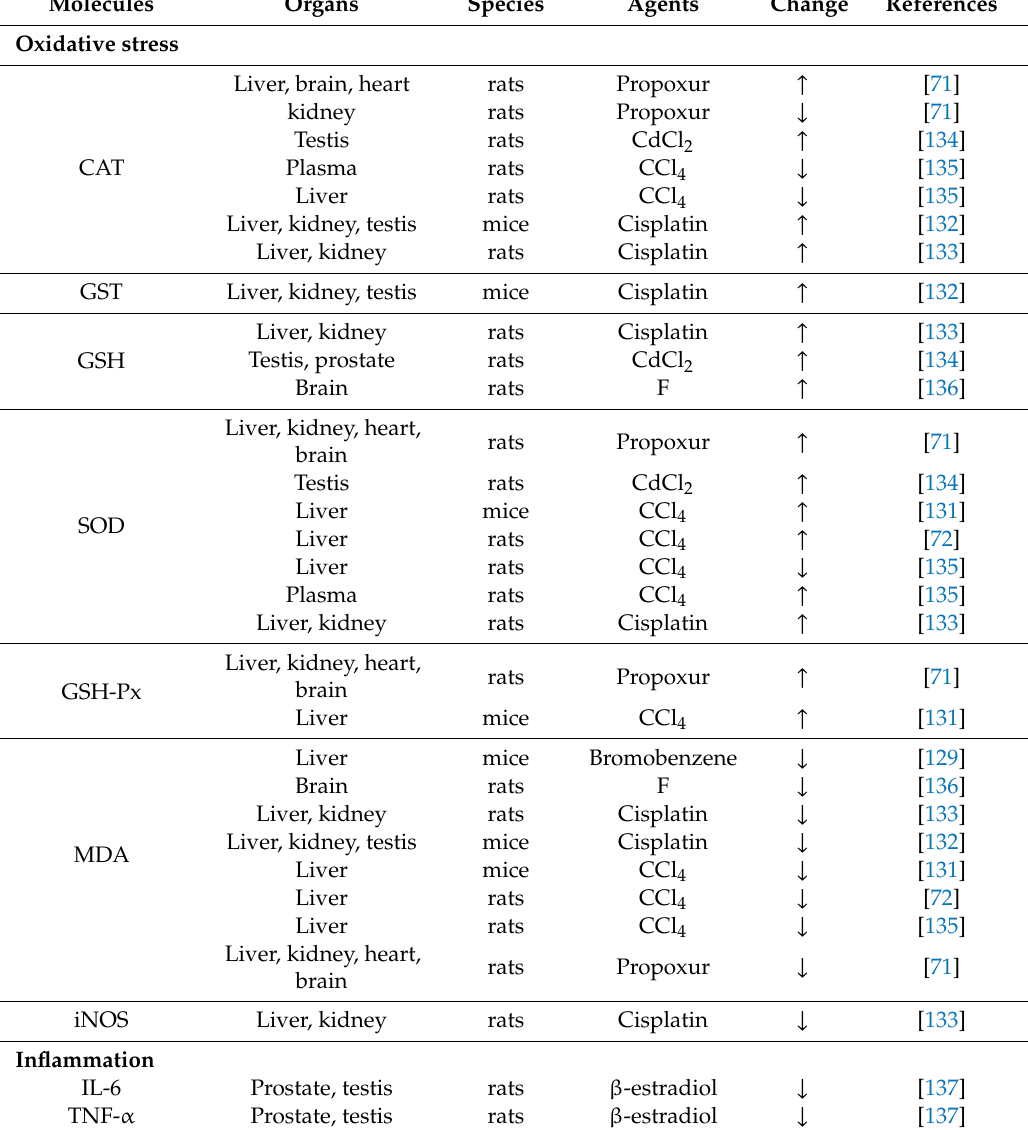
Table 5. Enzyme-level changes induced by BB in response to anti-cancer therapies.